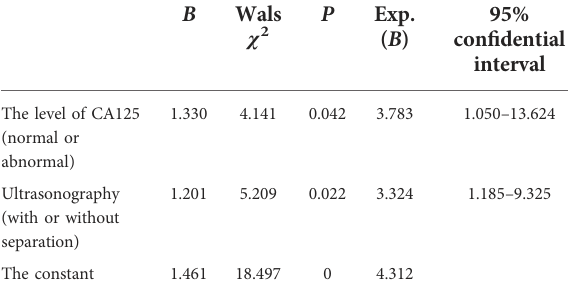
TABLE 5 The logistic regression analysis of the in fl uencing factors for the recurrence of borderline ovarian